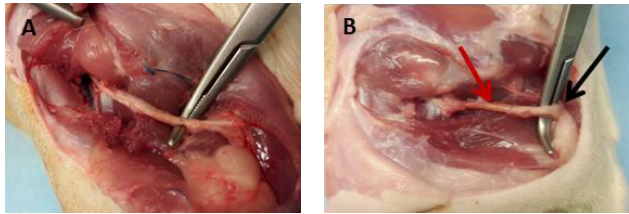
Figure 4. ( A ) autologous nerve graft; ( B ) hUA graft. The red arrow indicates the graft and the black arrow indicates the nerve tissue.